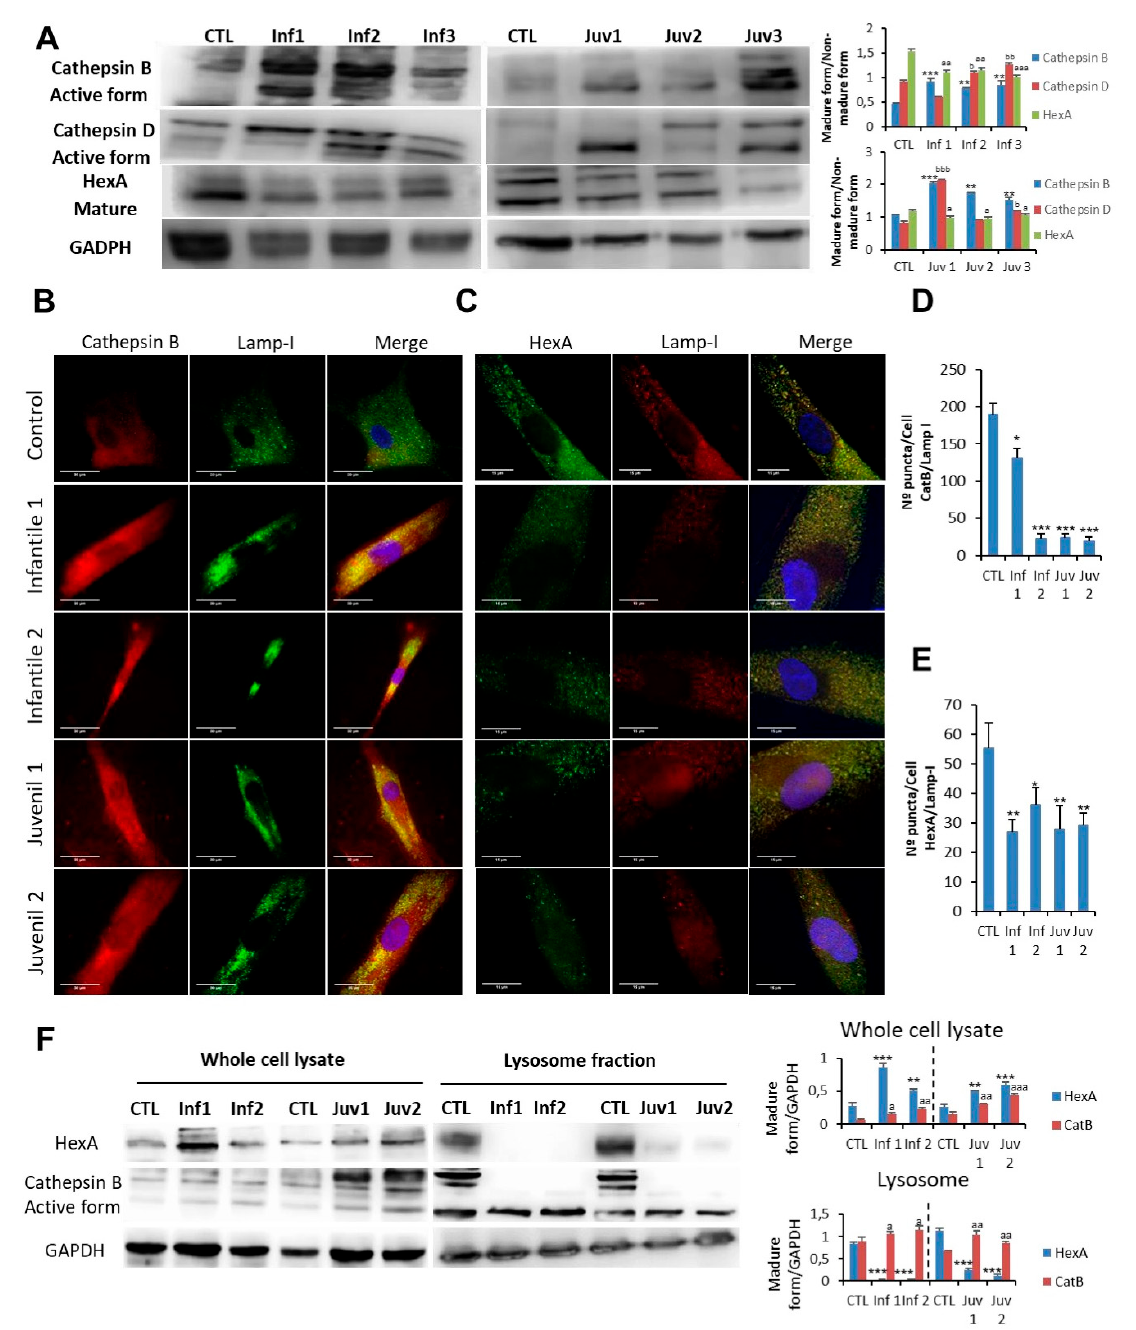
Figure S2, immunoreactive TFEB were abundant and concentrated in nuclei of fibroblasts obtained from patients with both subtypes of GM2 gangliosidosis.